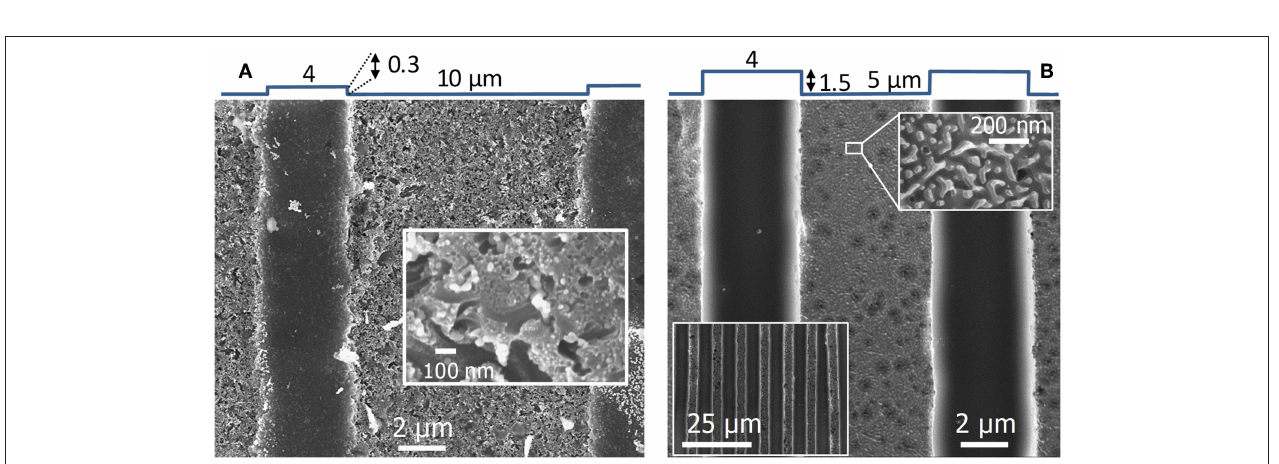
FIGURE 5 | SEM images of silicon surfaces after imprinting U-shaped lines with np-Au electrode: (A) fine nanostructure (0.3 V SME , 20 min ) ; (B) coarse nanostructure (0.2 V SME , 20min). Insets: (A, B-upper) high magnification image of the etched area; (B-bottom) U-shaped line array at a lower magnification. Electrolyte: HF 5mol L − 1 with 2 vol.% EtOH.